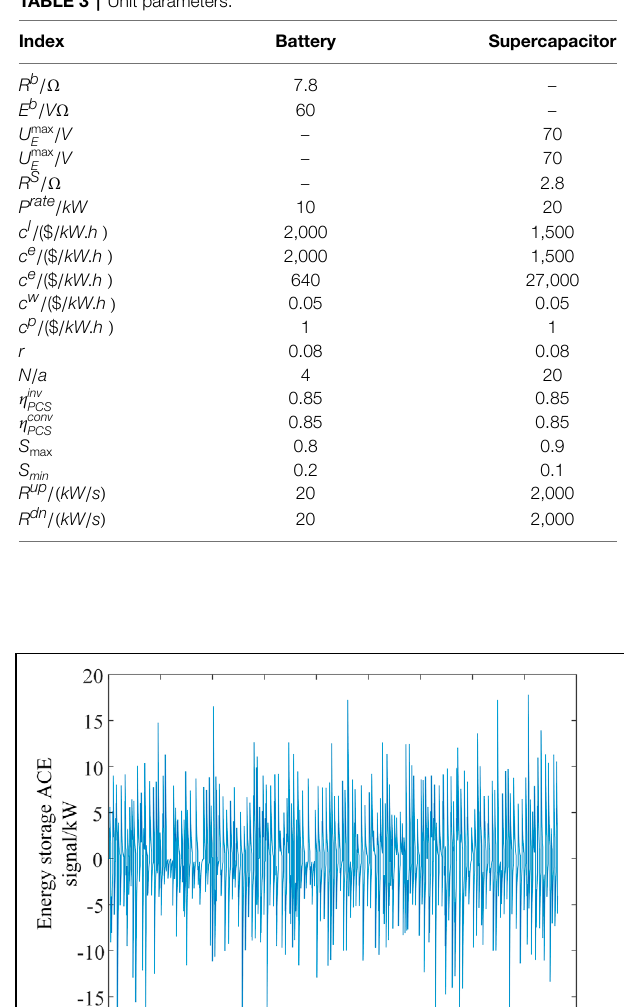
strategies are shown in Table 5 . In energy storage output